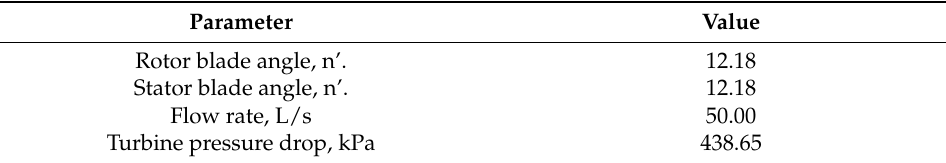
Figure 2. Model calculation in the «Setup» section: a —flow rate, b —pressure drop. Table 2. Input data for model calculation in Ansys Workbench.